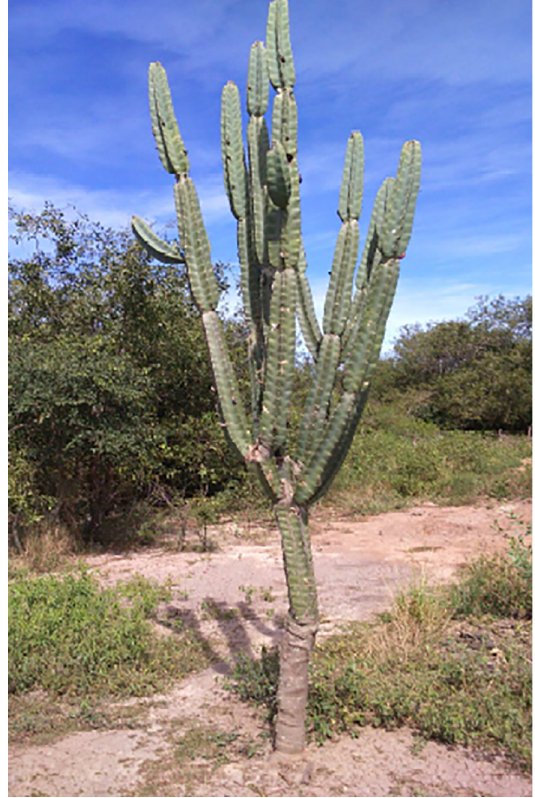
Figure 1. Photograph of the Cereus Forbesii, native cactus of arid regions of South America.